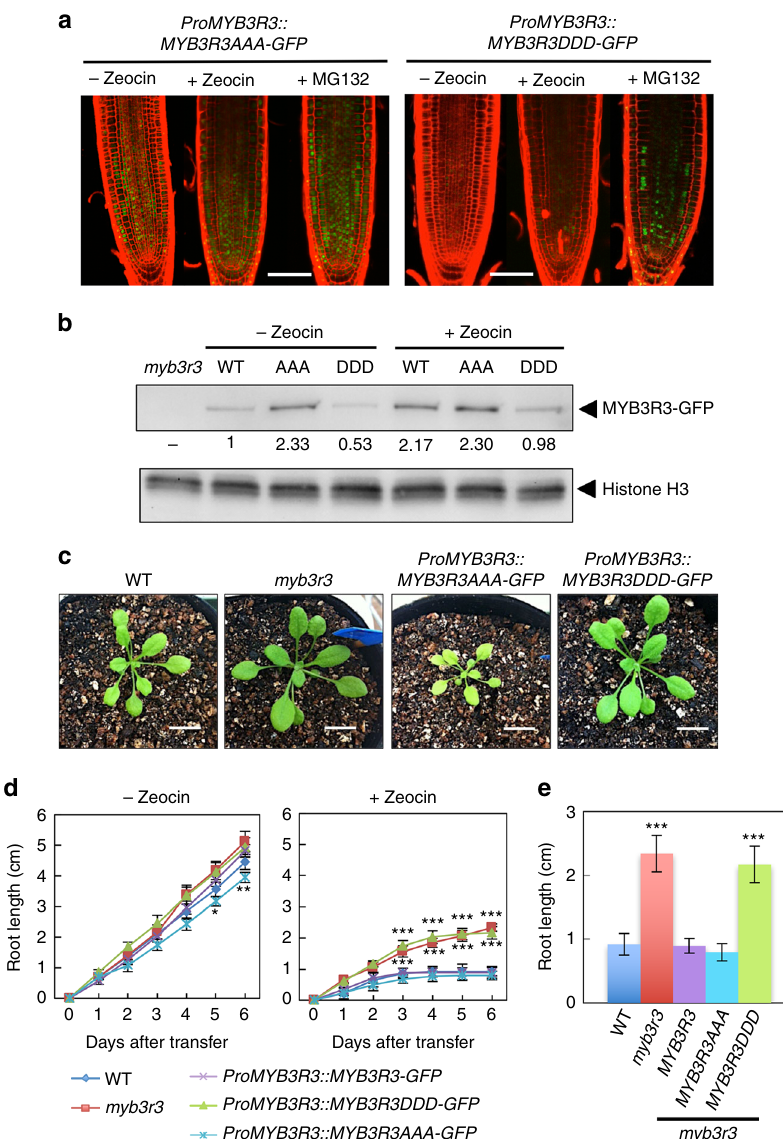
Fig. 6 Phosphorylation state of MYB3R3 is associated with protein accumulation and zeocin response. a Confocal microscopy images of myb3r3 root tips harbouring ProMYB3R3::MYB3R3AAA-GFP or ProMYB3R3::MYB3R3DDD-GFP . Five-day-old seedlings were treated with or without 2 μ M zeocin, or with 50 μ M MG132, for 24 h. Scale bars , 100 μ m. b Protein level of MYB3R3-GFP in roots. Ten-day-old myb3r3 seedlings harbouring ProMYB3R3::MYB3R3-GFP (WT) , ProMYB3R3::MYB3R3AAA-GFP (AAA) or ProMYB3R3::MYB3R3DDD-GFP (DDD) were treated with or without 2 μ M zeocin for 24 h, and 40 µ g of total protein extracted from roots was immunoblotted with anti-GFP or anti-histone H3 antibodies. Protein extract from myb3r3 was used as a control. Relative levels of MYB3R3-GFP are expressed as the fold change, normalized with respect to the band of histone H3. c Eighteen-day-old seedlings of WT, myb3r3 and myb3r3 carrying ProMYB3R3::MYB3R3AAA-GFP or ProMYB3R3::MYB3R3DDD-GFP . Scale bars , 2 cm. d , e Root growth of WT, myb3r3 and myb3r3 carrying ProMYB3R3::MYB3R3-GFP , ProMYB3R3::MYB3R3AAA-GFP or ProMYB3R3::MYB3R3DDD-GFP . Five-day-old seedlings were transferred to medium with